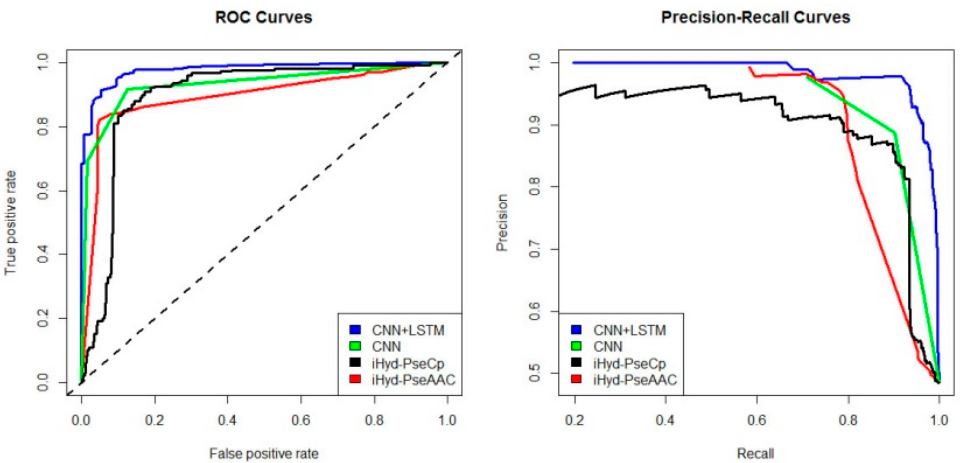
Figure 7. The ROC and Precision-Recall curves to show the performance of CNN+LSTM, CNN, iHyd-PseCp and iHyd-PseAAC for the peptide samples with the center residue being proline on Dataset 6.